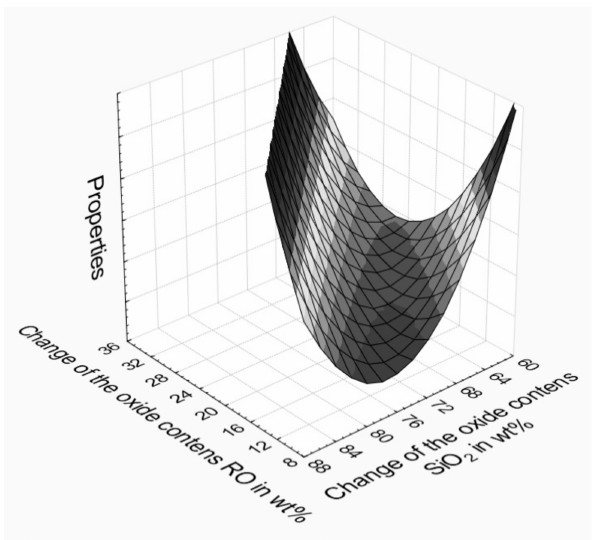
Figure 2. Changes in properties of aluminosilicate glasses related to their chemical composition (RO: CaO +